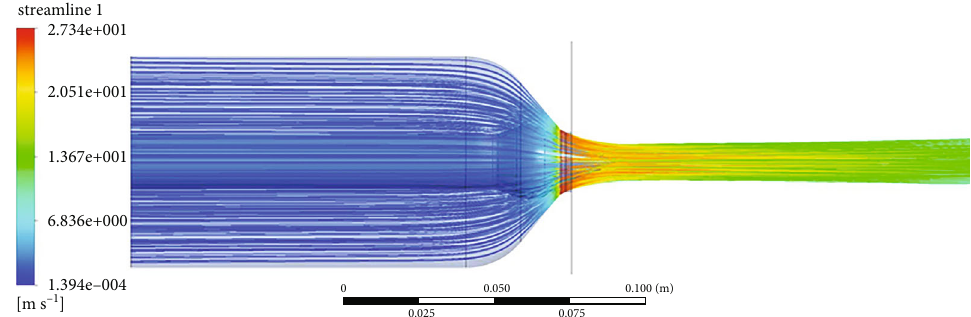
Figure 8: Flow streamline (half open nozzle).